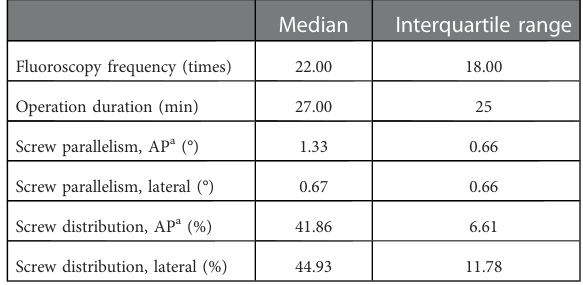
TABLE 2 The intraoperative statistics of ten children with femoral neck fractures treated by robot assisted internal fi xation.